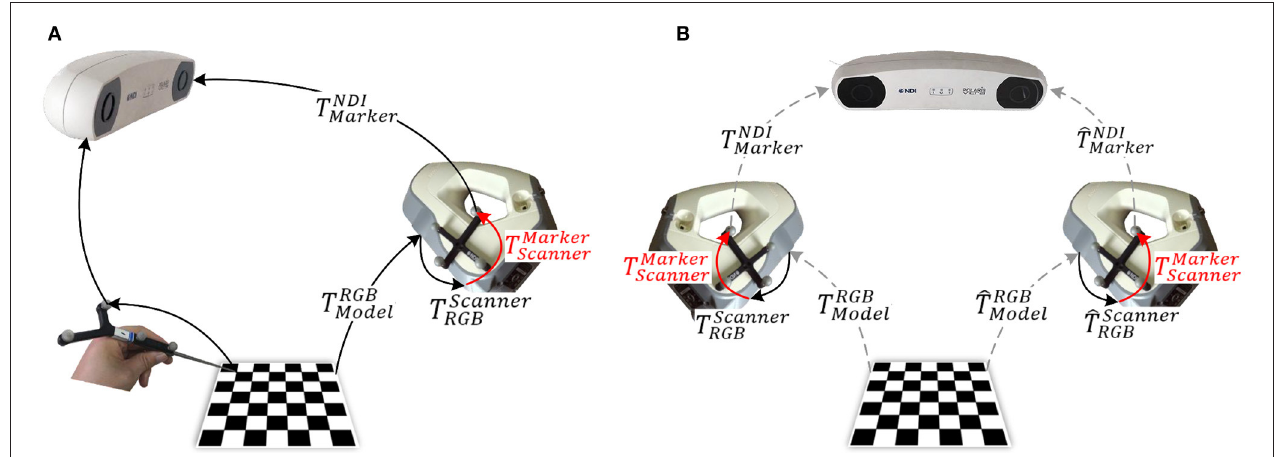
FIGURE 2 | Methods for 3D scanner calibration based on a 2D checkerboard: (A) closed-form solution (Pick-2D): pick points using a tracked pointer; and (B) numerical solution (Hand–Eye-2D): based on hand–eye calibration algorithm.